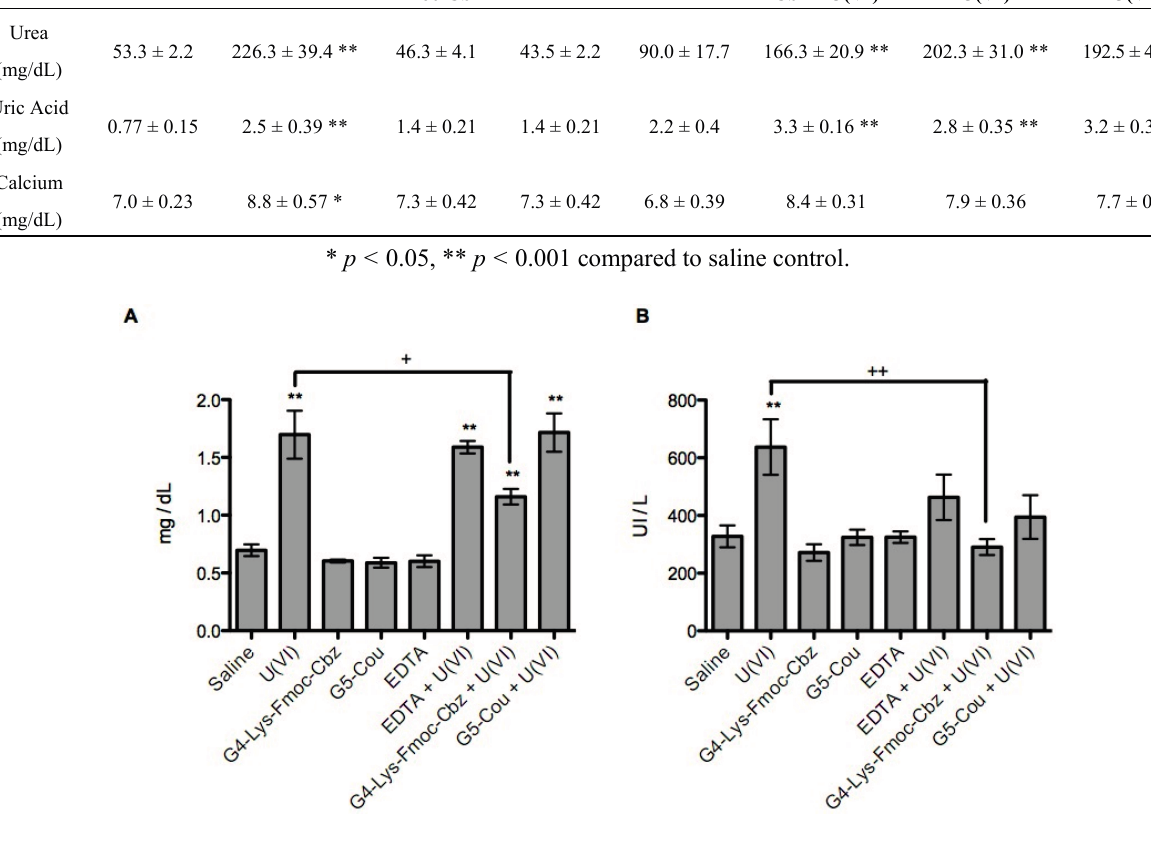
Figure 5. Effectiveness of dendrimers G4-Lys-Fmoc-Cbz and G5-Cou on plasma concentrations of creatinine ( A ) and LDH ( B ). ** p < 0.001 compared with the saline control. + p < 0.05; ++ p < 0.001 compared with the U(VI)